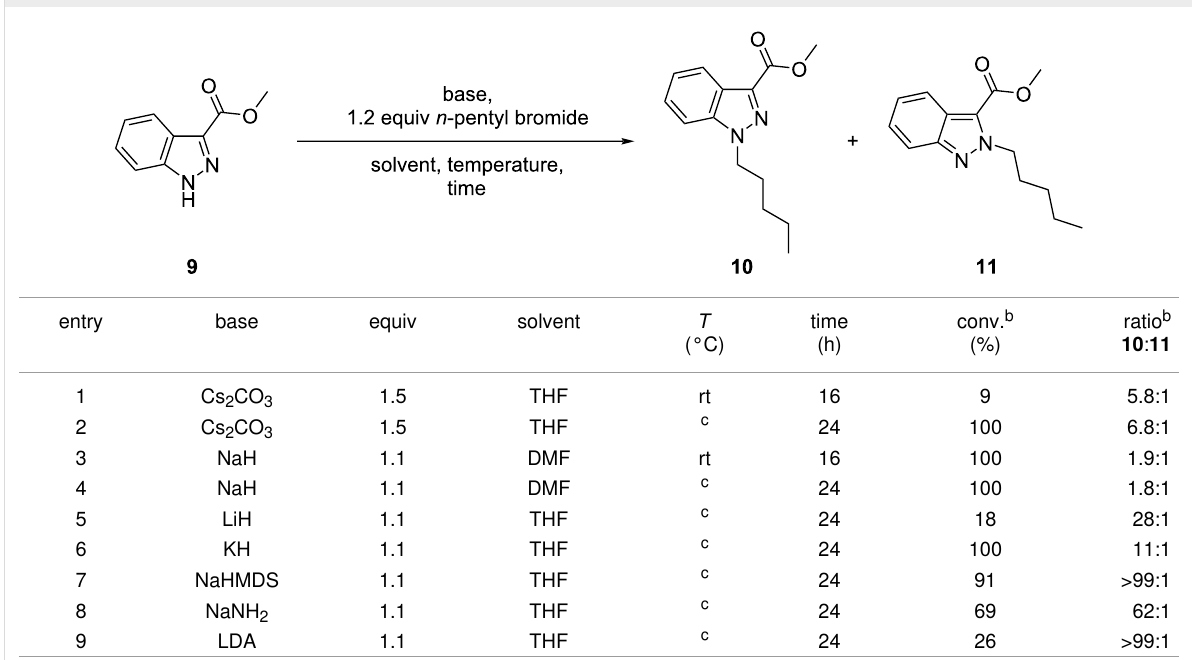
Table 3: Effect of NaH and THF on N -1 regioselectivity. a